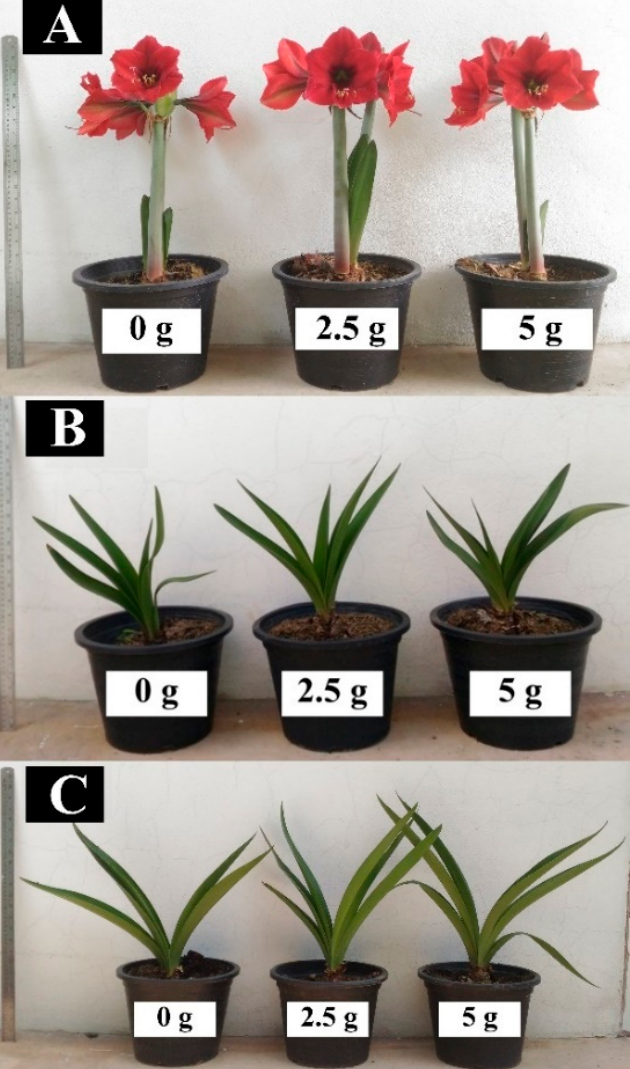
Figure 1. Growth of Hippeastrum ‘Red Lion’ after fertilization at different rates 45 ( A ), 60 ( B ), and 90 ( C ) days after planting. Table 1. Effect of fertilization rates on growth and Hippeastrum ‘Red Lion’ at different growing stages. Fertilization Rate